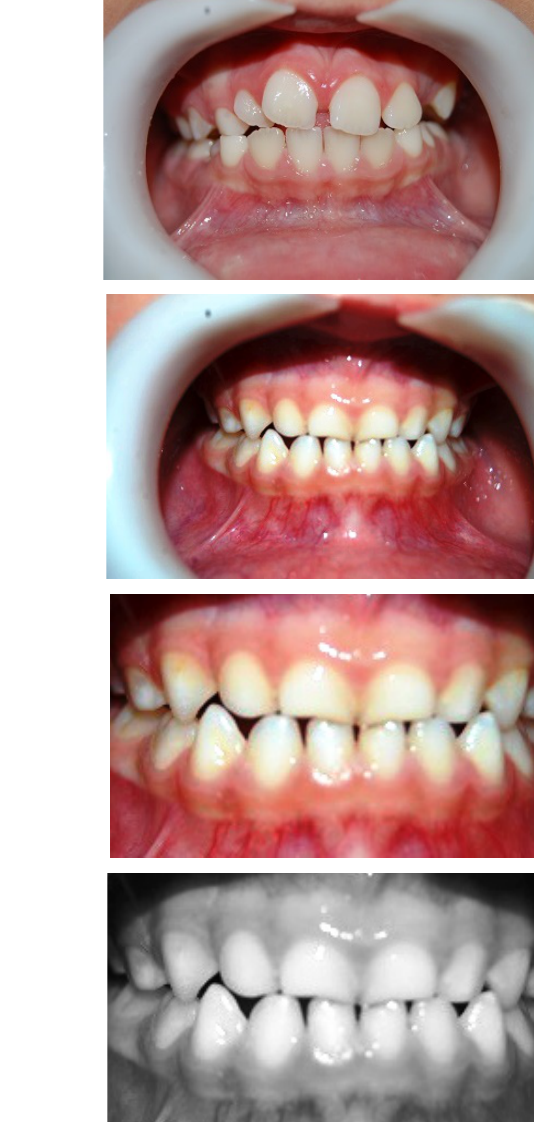
Figure 5. Cropping. ( A ) Input image, ( B ) contrast enhancement, ( C ) cropped enhanced image, ( D ) grayscale cropped enhanced image.